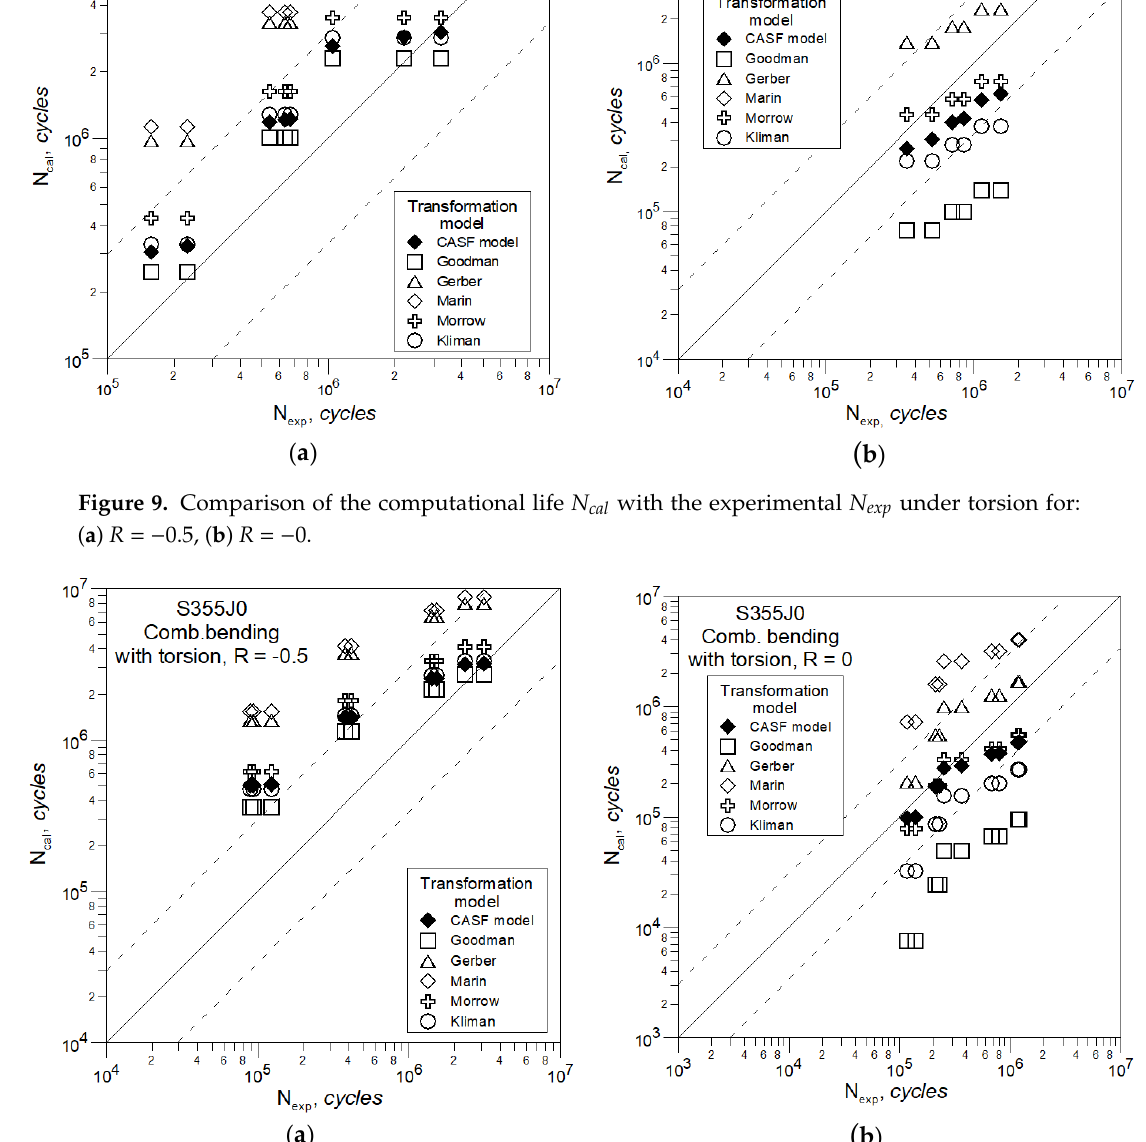
Figure 10. Comparison of the computational life N cal with the experimental N exp under bending and torsion for: ( a ) R = −0.5, ( b ) R = −0.